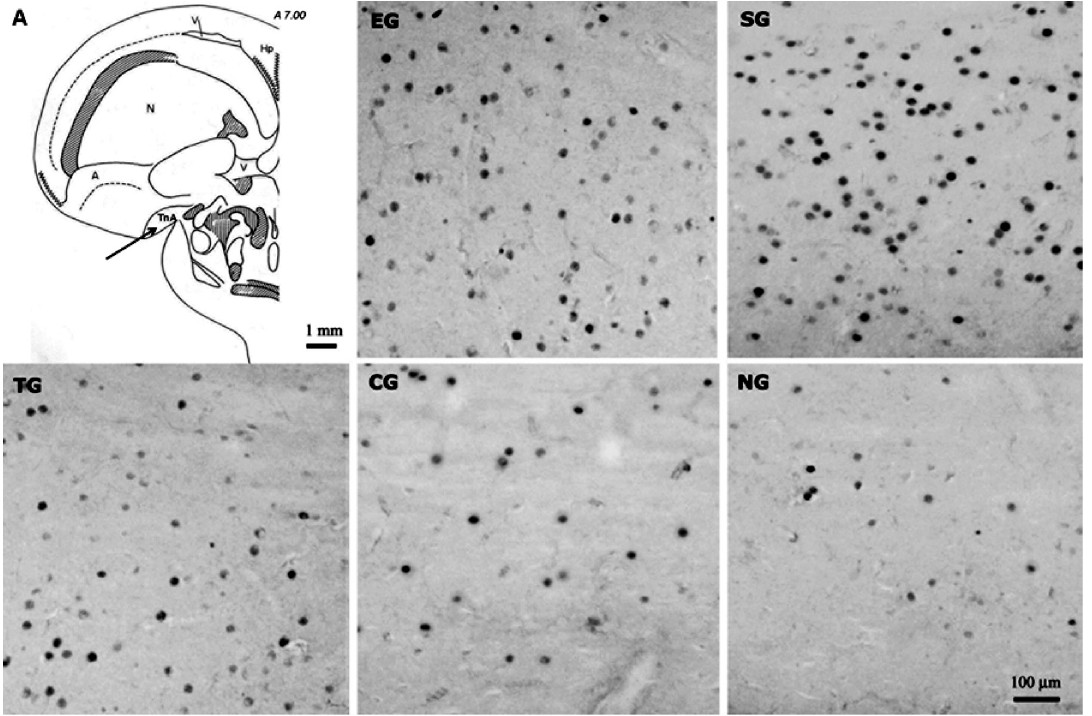
Figure 2. A , Schematic presentation of frontal sections of the pigeon’s brain showing the nucleus taeniae of the amygdala (TnA) reprinted with permission from Karten and Hodos (20). EG , SG , TG , CG , and NG , Digital images of frontal sections of the amygdala of pigeons of the experimental group (EG), shock group (SG), tone group (TG), context group (CG), and naive group